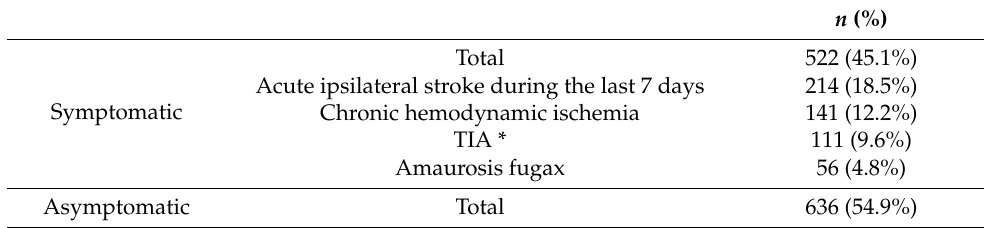
* transient ischemic attack.